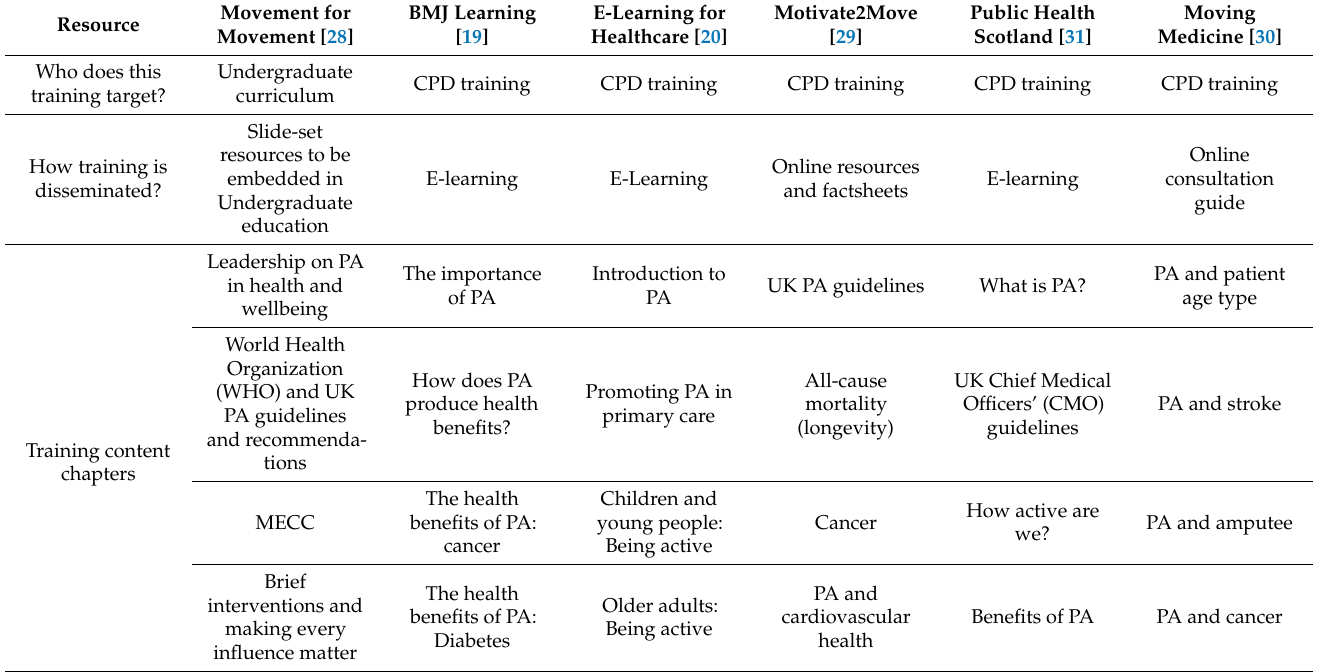
Table 3. Contents and dissemination strategy for CPD training and undergraduate curricula resources identified in the